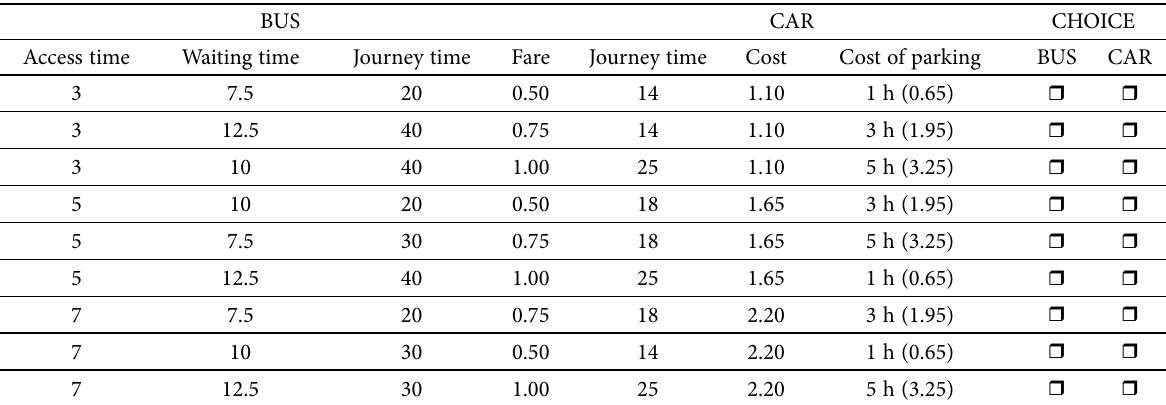
Table 3. Form and results for the survey Bus vs. Car